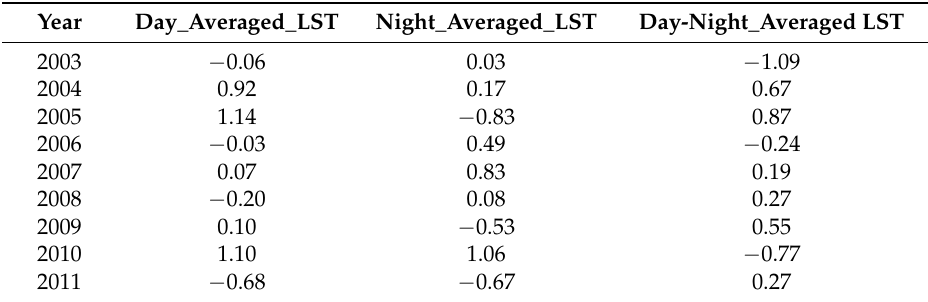
Table 5. Averaged values of annual AATSR-derived LST departure from the nine-year (2003–2011) average shown as Figure 6 in the